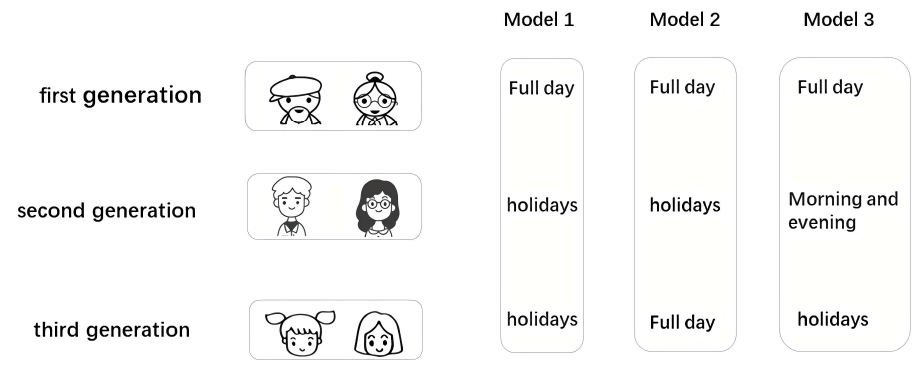
Figure 4. Rural household models.